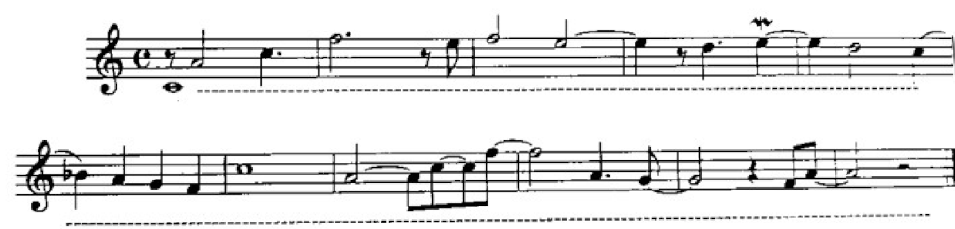
Figure 3. This is the music score of what Tina sang repeatedly, but with some small